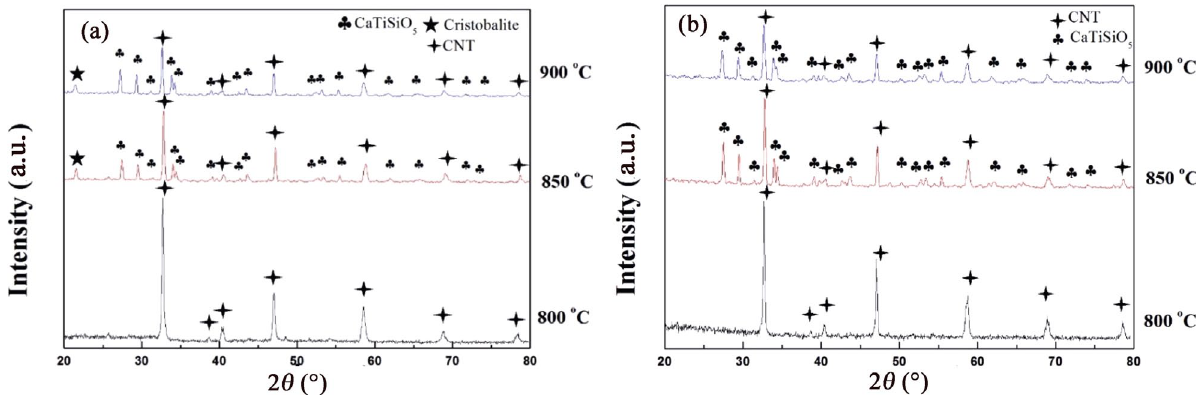
Fig. 2 XRD patterns of Ca 0.7 Nd 0.2 TiO 3 powders added with 50 wt% C1 (a) and C1A03 (b) glass powders and sintered at various